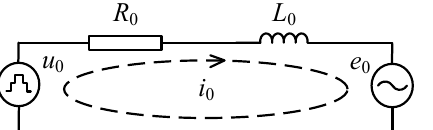
Figure 2. Series-winding topology for a three-phase PMSM drive.